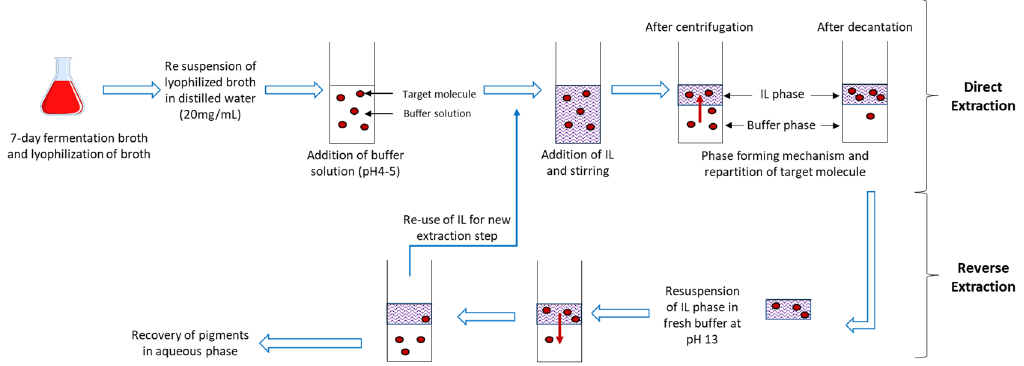
Figure 1. Brief description of the overall ideal IL aqueous two-phase system (IL-ATPS) workflow for direct detection and extraction of fungal pigments into ionic-rich phase, their back-extraction into salt- rich solution and re-injection of IL into the